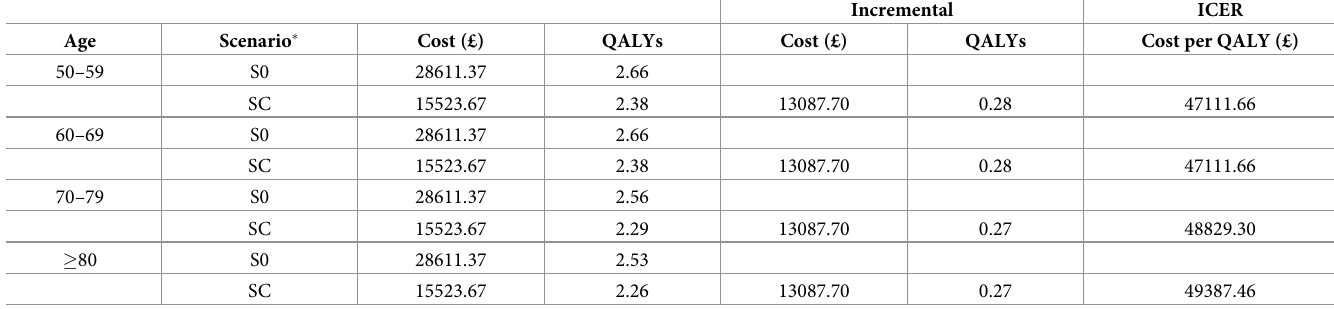
Table 12. Cost-effectiveness results for continuous FlowOx ™ therapy plus nominal care compared to standard